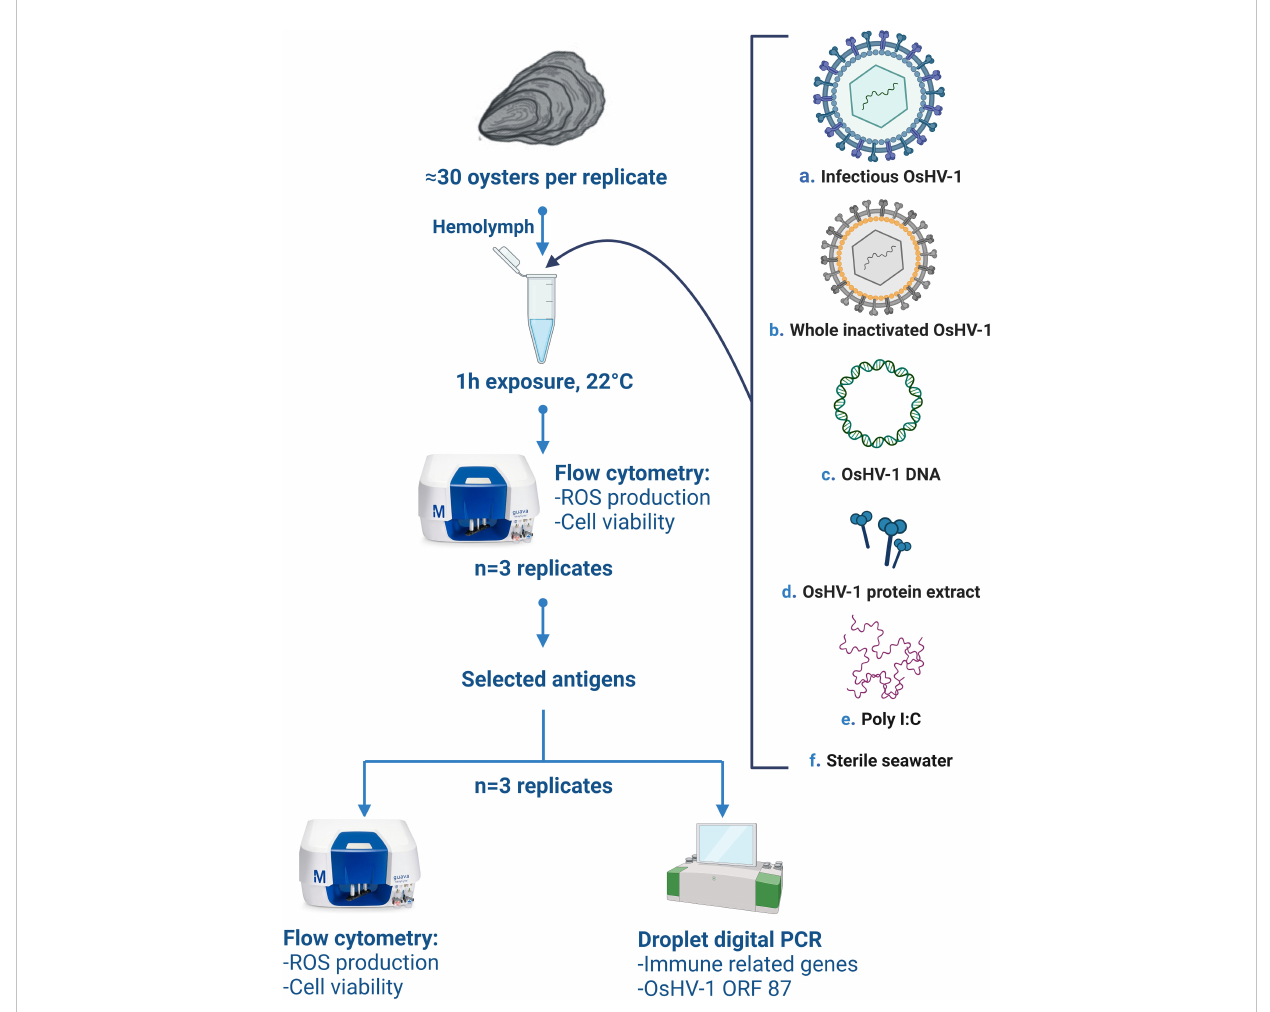
FIGURE 1 Schematic overview of the in-vitro experimental design, (A) refers to the live infectious OsHV-1, (B) whole virus killed by chemical (BEI, formaldehyde), heat inactivated, or exposed to freeze-thaw cycles, (C) OsHV-1 DNA, (D) OsHV-1 whole protein extract, (E) Poly (I:C, positive control), (F) sterile fi ltered seawater (negative control). ROS stands for ‘ reactive oxygen species ’ , ORF to ‘ open reading frame ’ . Figure was created using